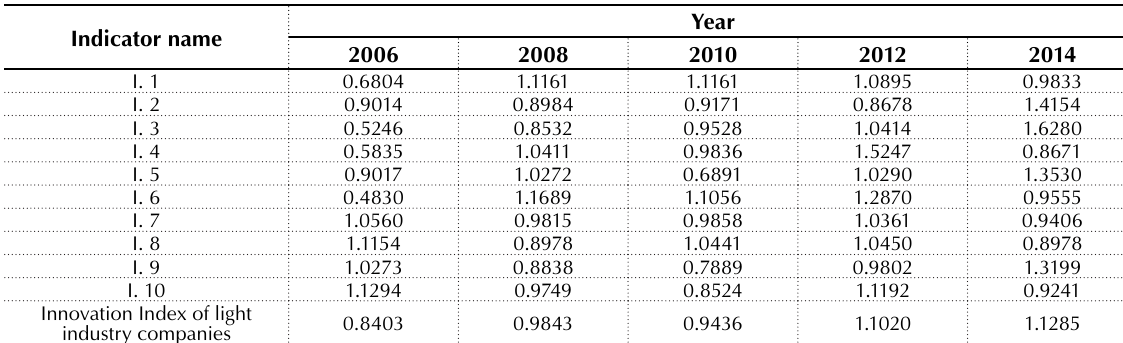
Table 4. The normalized values of indicators of innovation activity and the Innovation indexes of light industry companies in the EU countries